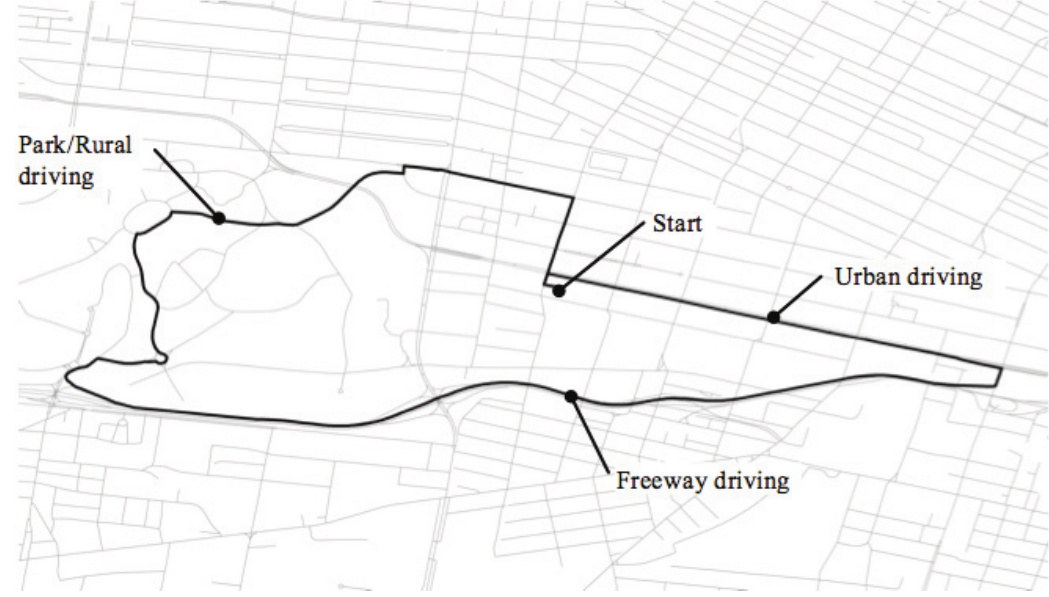
Figure 1. Structured driving